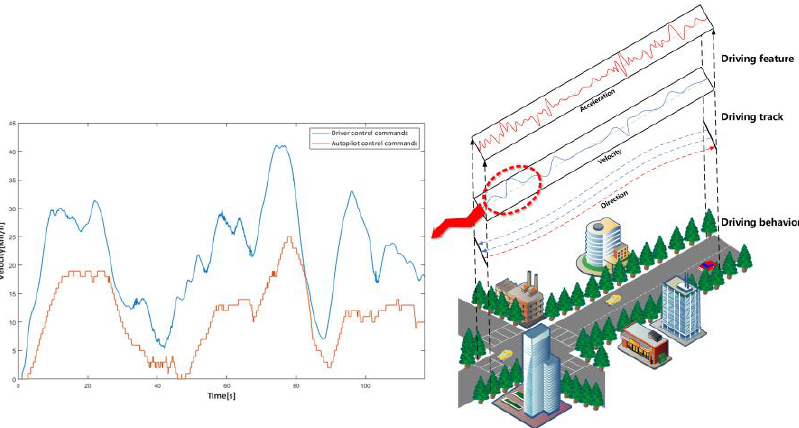
Figure 1. Control command discrepancies between the pilot and the autopilot.